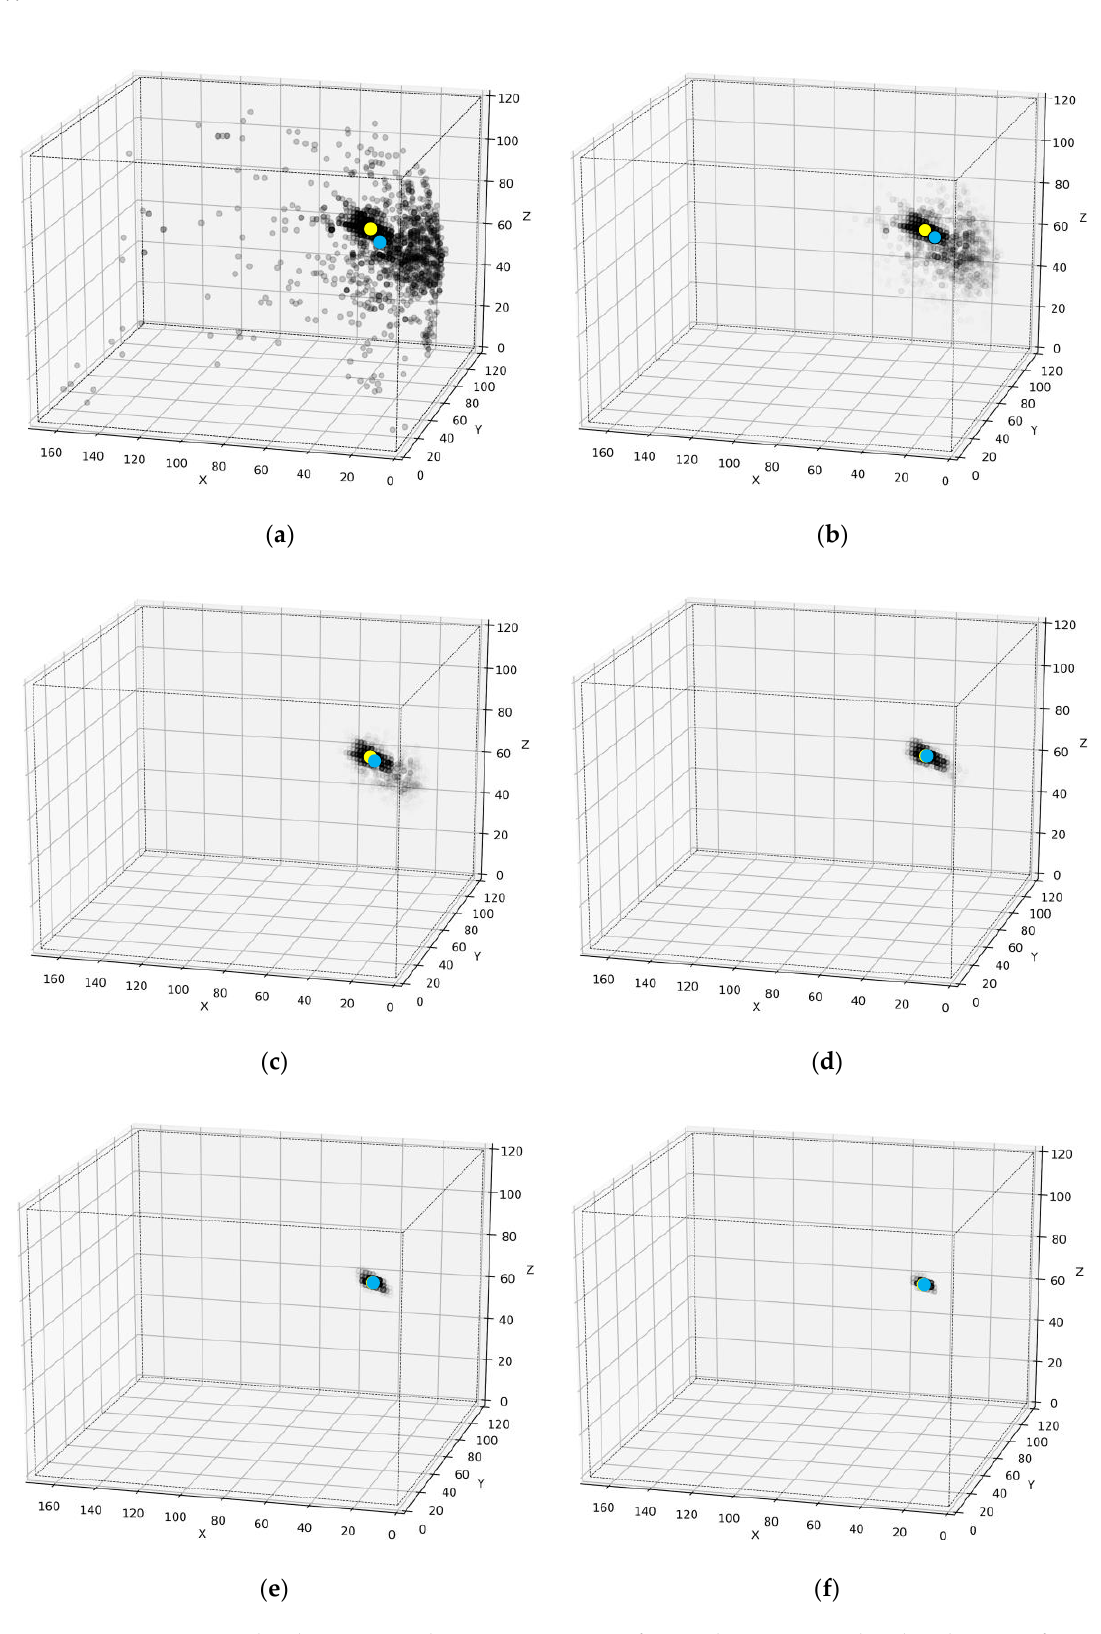
Figure 10. Target localization results using IMWLE after each iteration. The distribution of pseudo-targets after ( a ) the first iteration, ( b ) the second iteration, ( c ) the third iteration, ( d ) the fourth iteration, ( e ) the fifth iteration, and ( f ) the sixth iteration.